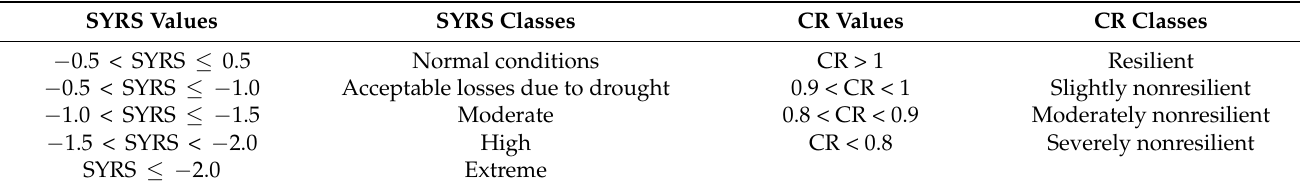
Table 3. Classification of SYRS and CR.